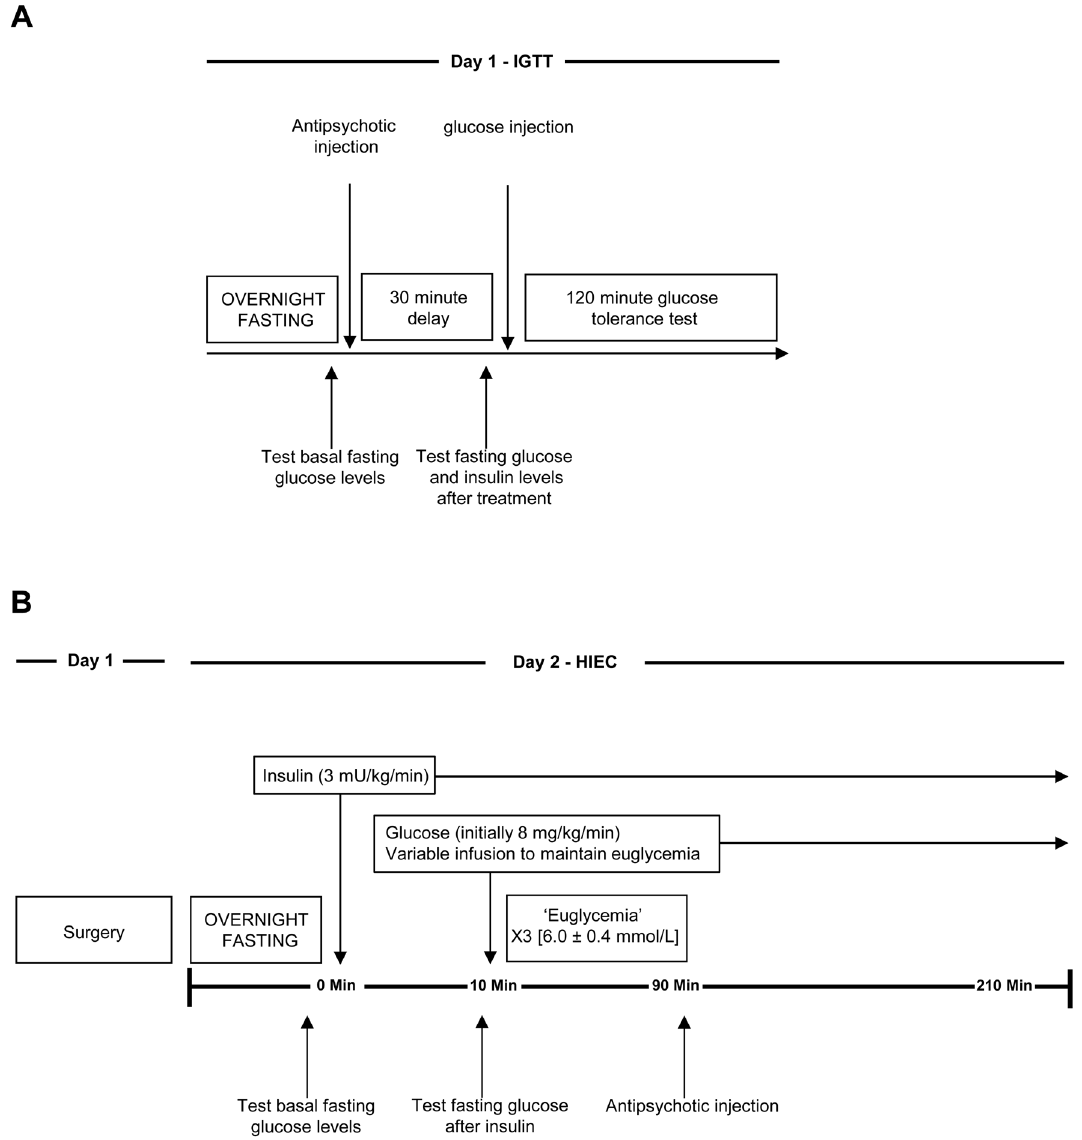
Figure 1. Experimental protocol. Describing ( A ) the intraperitoneal glucose tolerance test and ( B ) the hyperinsulinemic-euglycemic clamp with acute antipsychotic drug